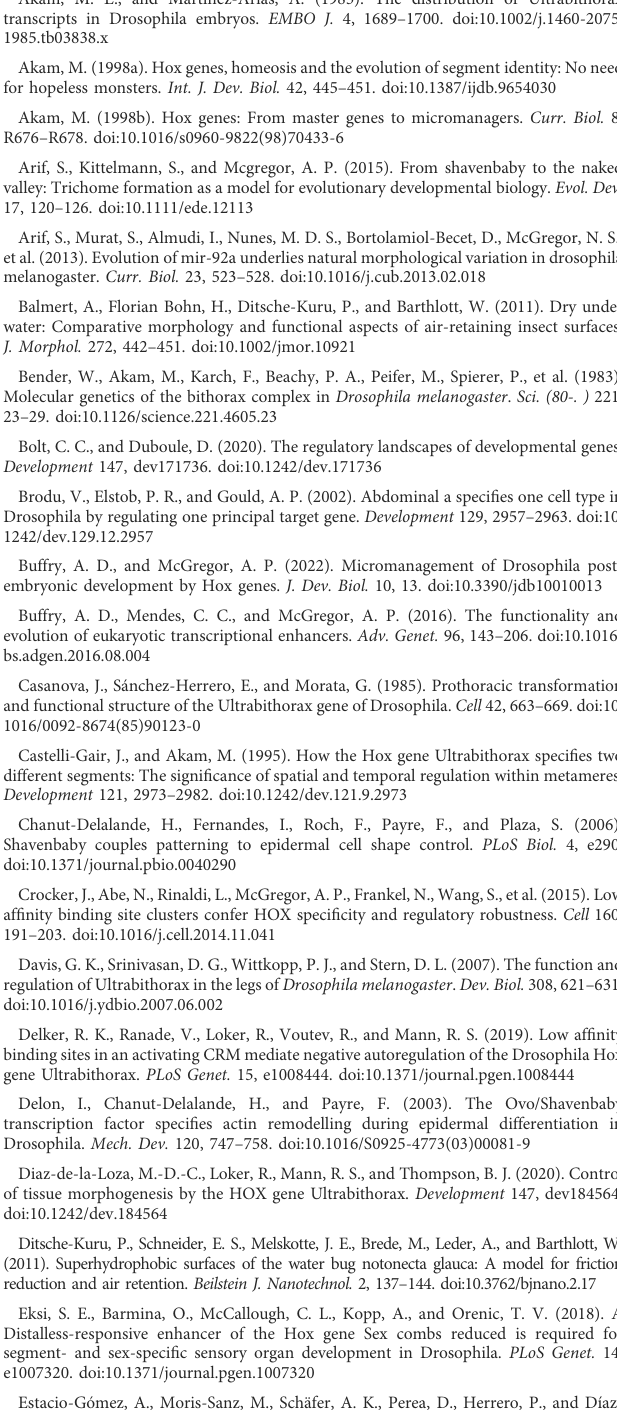
SUPPLEMENTARY MATERIAL S1 (DATA SHEET 1) A list of all the fl y stocks used in this study. SUPPLEMENTARY MATERIAL S2 (DATA SHEET 2) Coordinates of reporter lines, primer sequences of reporter constructs and RedFly annotated regulatory regions for the Ubx locus.